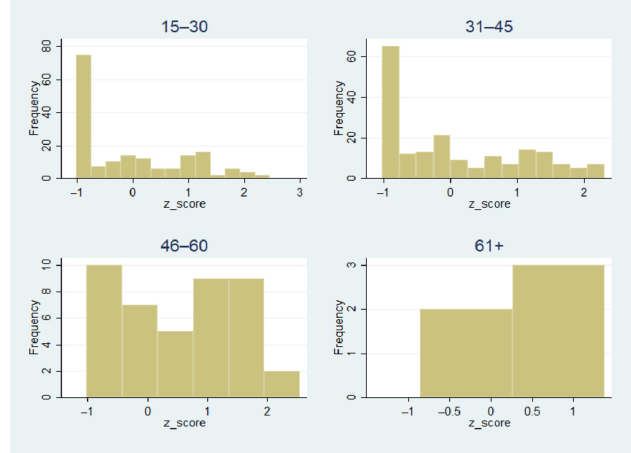
Figure 3. Financial literacy scores by age group.